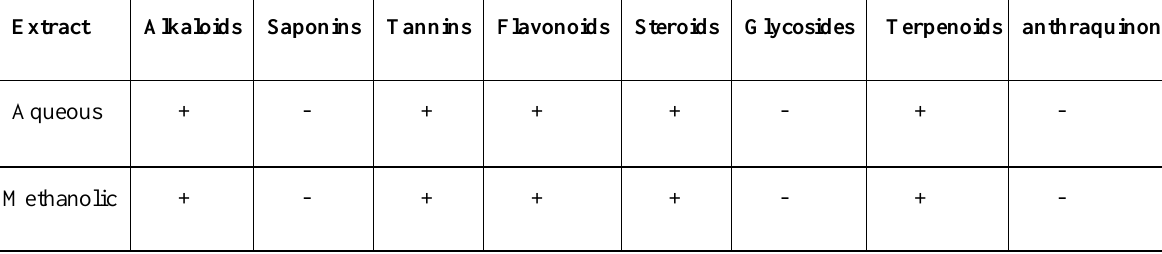
Table 2. Phytochemical constituents of C. sinensis leaf extract. Extract